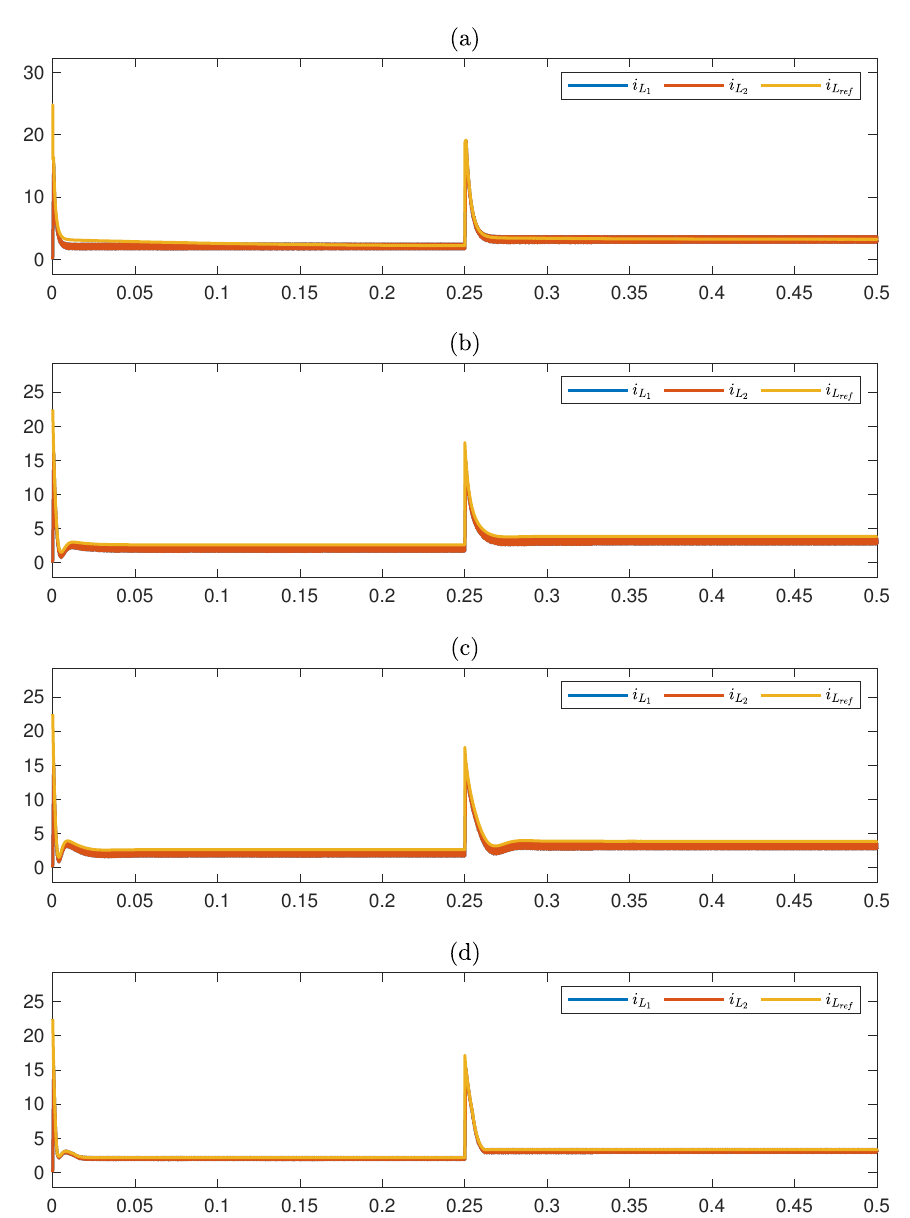
Figure 4. ( a ) The inductor currents of the FIBC under the C1 controller. ( b ) The inductor currents of the FIBC under C2 controller. ( c ) The inductor currents of the FIBC under C3 controller. ( d ) The inductor currents of the FIBC under proposed controller